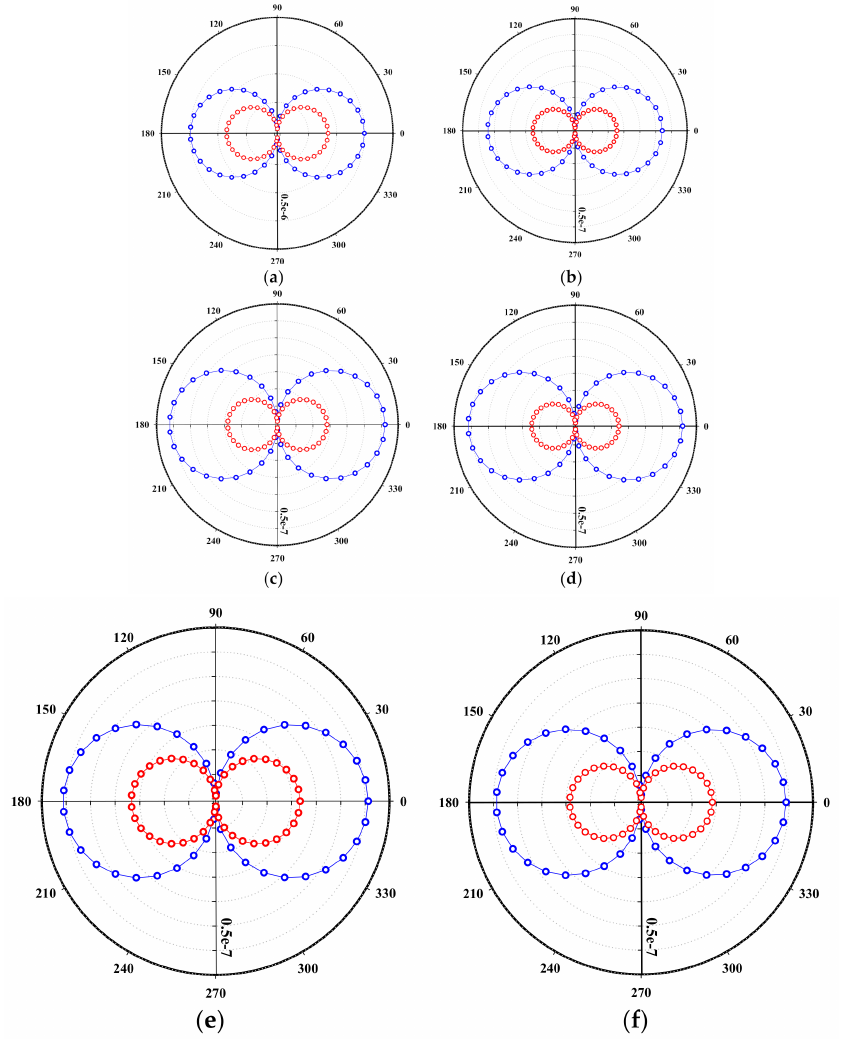
Figure 12. Directivity of root mean square SPL due to the fluctuation of drag (rod; red-solid line, Rod-Airfoil and airfoil; blue-solid line): ( a ) A/C = 0, ( b ) A/C = 0.02, ( c ) A/C = 0.04, ( d ) A/C = 0.06, ( e ) A/C = 0.08, ( f ) A/C = 0.1.